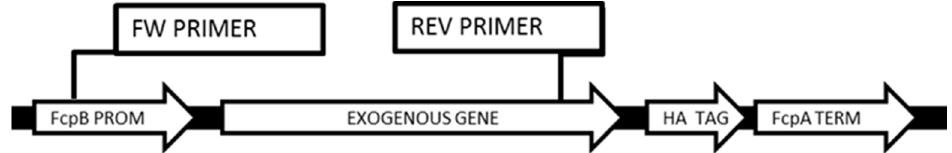
Figure 2. Schematic representation of the construct and position of the primers annealing sites used to screen exogenous gene integration.